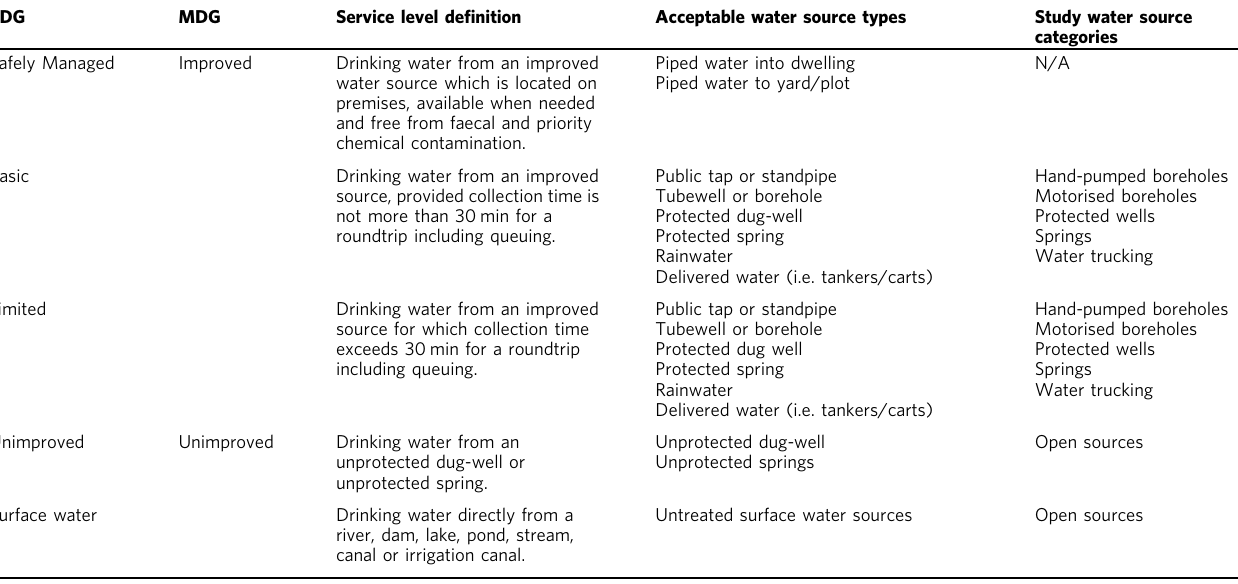
Table 1 Millennium Development Goals (MDG) and Sustainable Development Goals (SDG) water service levels, as de fi ned by WHO and UNICEF Joint Monitoring Programme (JMP), and examples of associated water source types 14,64